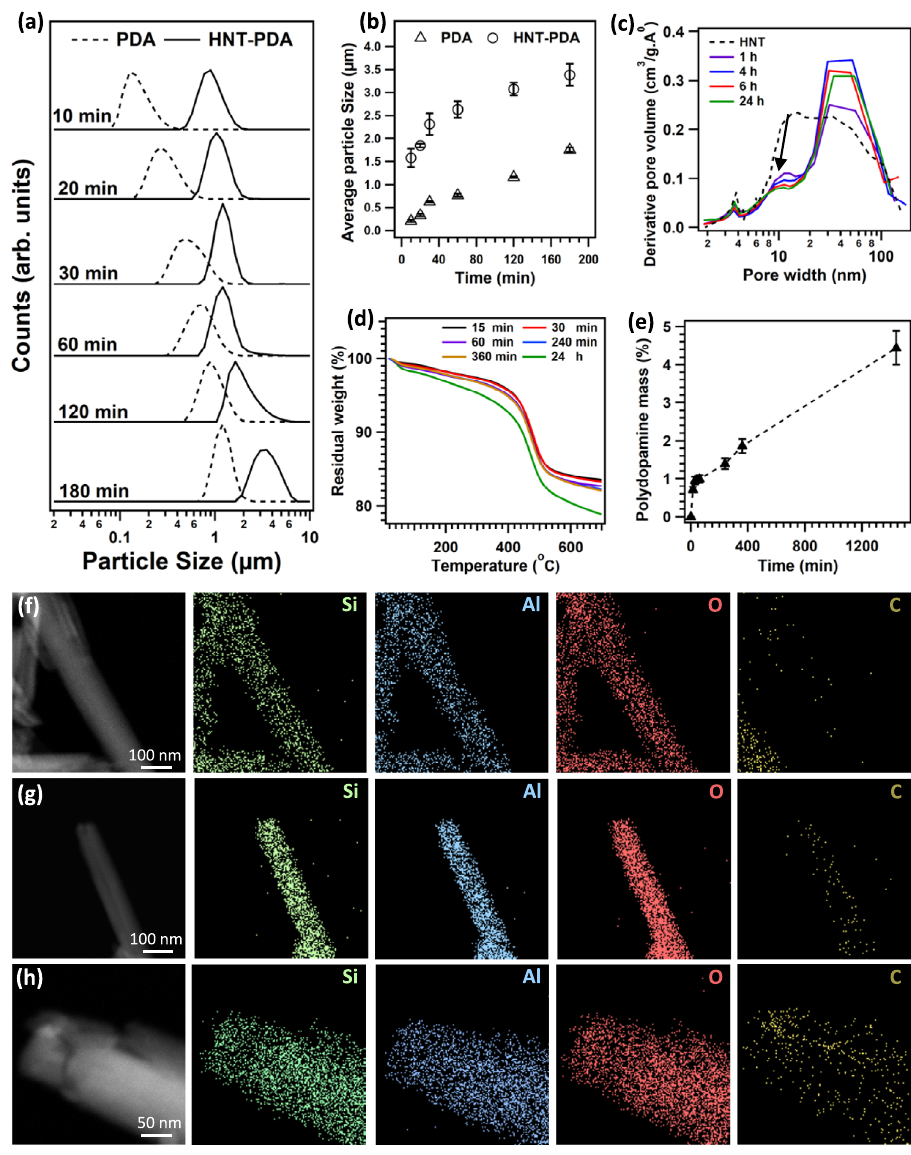
Fig. 2 | Formation and distribution of polydopamine on HNTs. a Particle size distributions — as deduced from dynamic light scattering of a dopamine solution afterdifferentpolymerizationtimeswithandwithouthalloysitenanotubes(HNTs); b time evolution of the particle size during polydopamine growth in the presence and absence of HNTs; c BJH pore size distribution; d TGA graphs for HNTs after different exposure times to the dopamine solution and e time evolution of the polydopaminemassdepositedontheHNTsurfaceduringpolymerization.Allerror